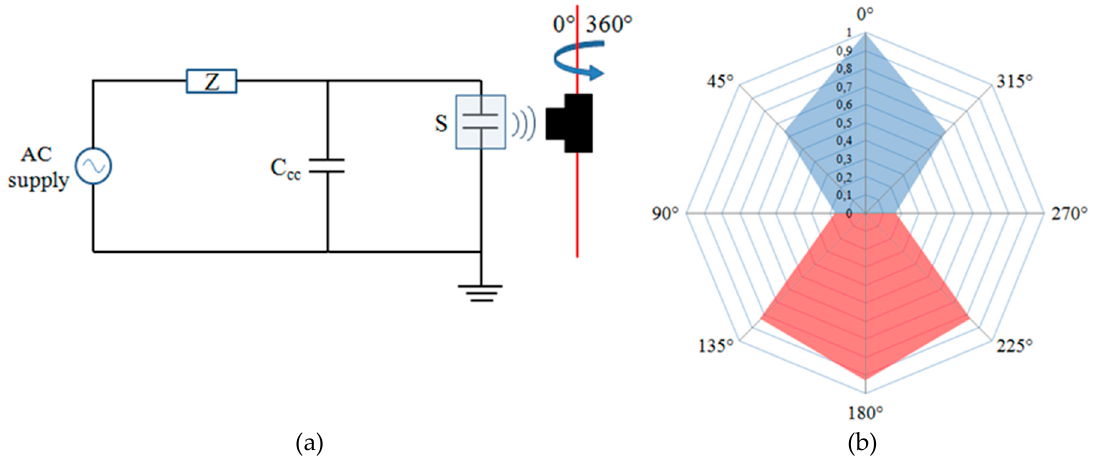
Figure 6. The IEC 60270 test circuit with ( a ) the corona emulator and ( b ) the PD pulse amplitude antenna response.